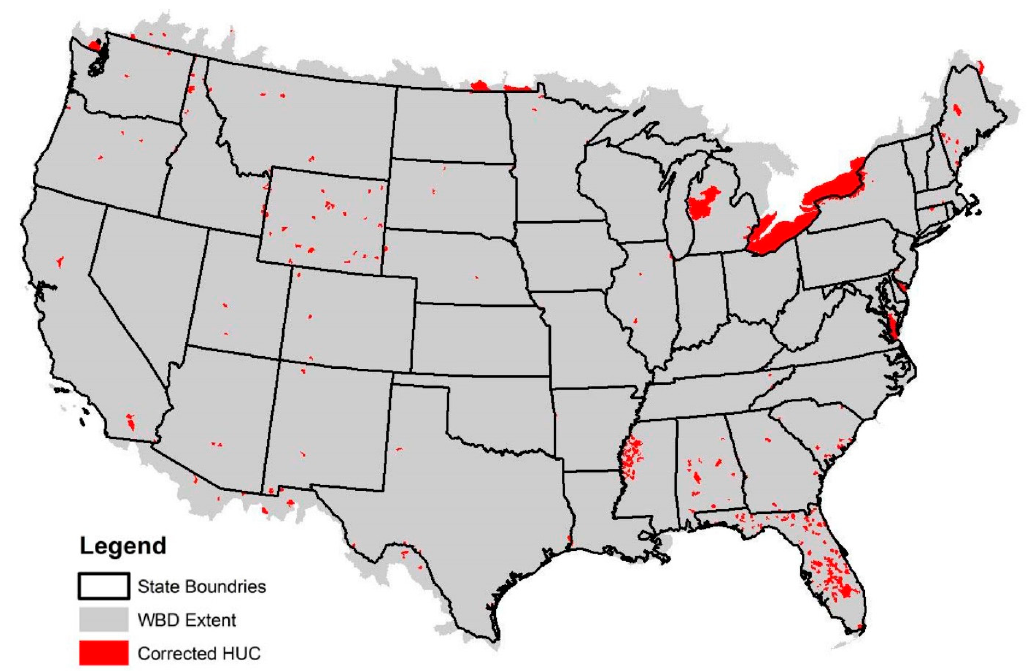
Figure 1. Corrections made in the drainage attribute for the Hydrologic Unit Code (HUC)-12 Watershed Boundary Dataset (WBD) snapshot used in this analysis.